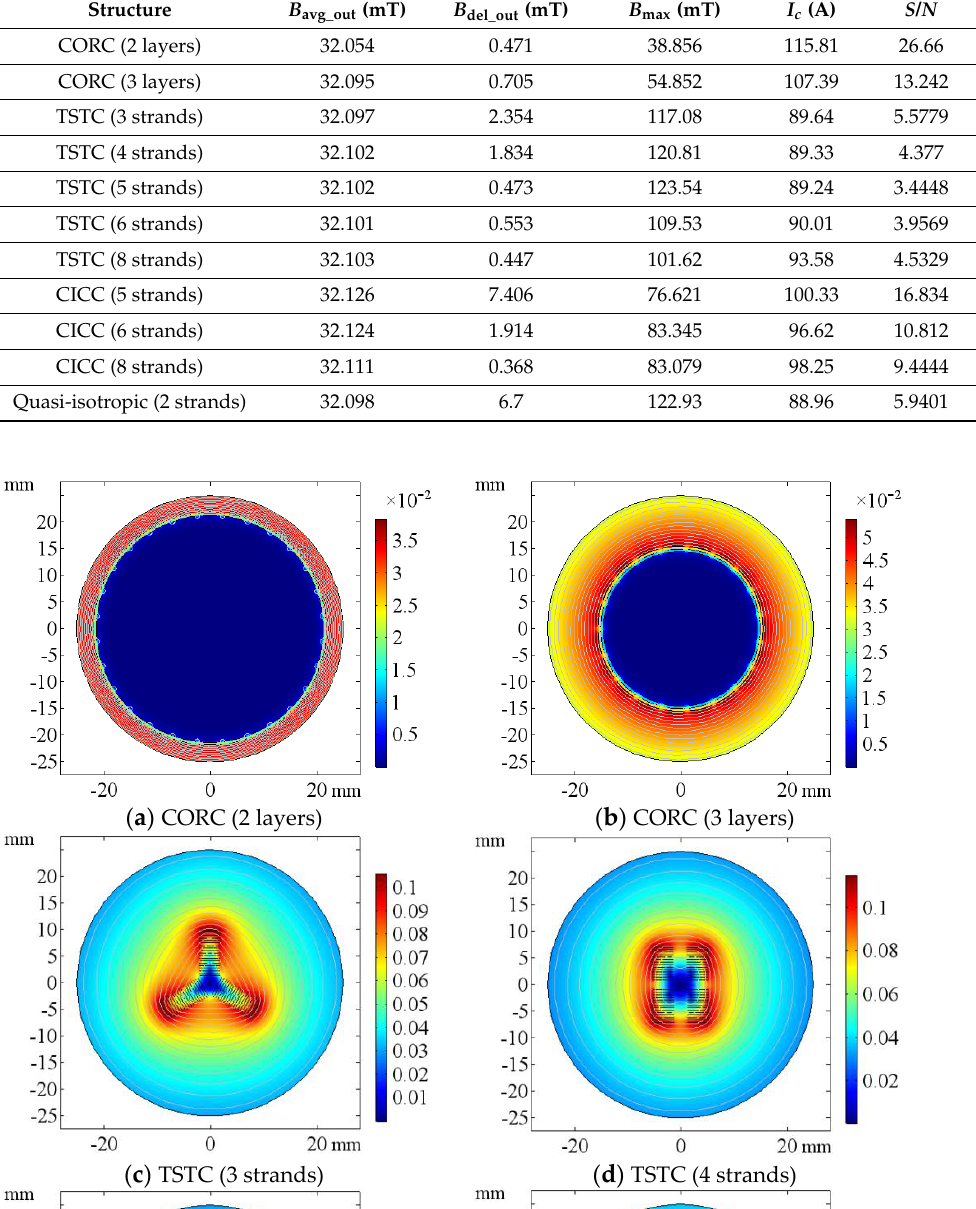
Table 2. Performance comparison of different conductor layouts.